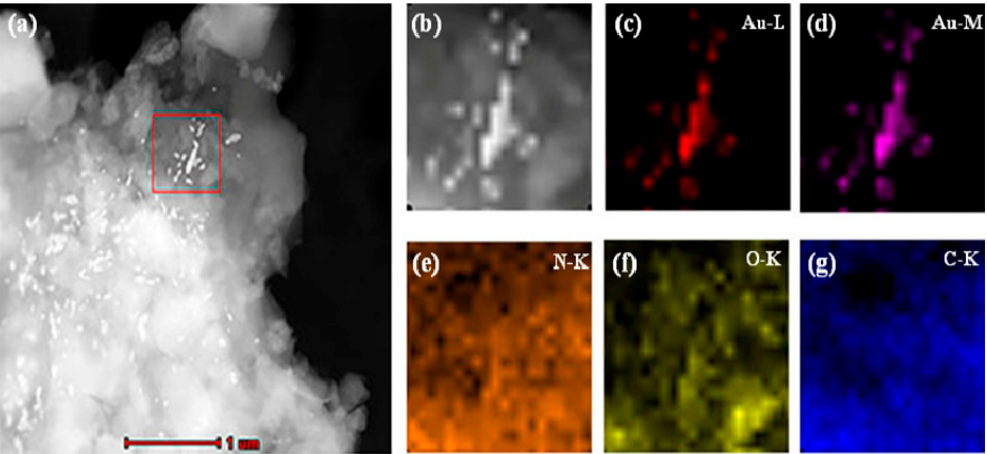
Figure 3. High-angle annular dark-field scanning transmission electron microscopy (HAADF-STEM) images ( a , b ) and compositional maps of gold ( c , d ), nitrogen ( e ), oxygen ( f ), and carbon ( g ) of the positively charged Au NPs-embedded MIHs.